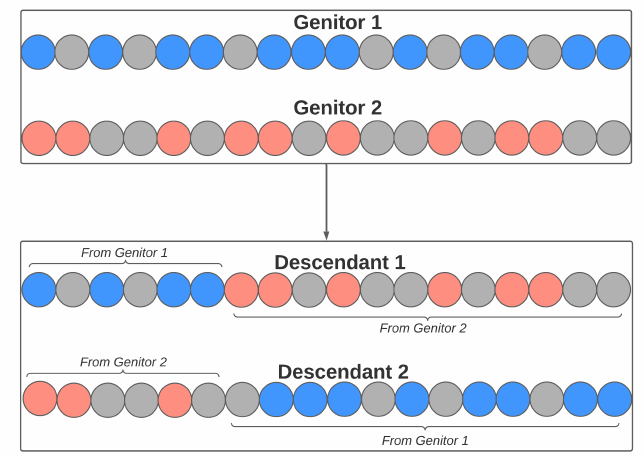
Figure 10. Crossover reproduction in the feature selection